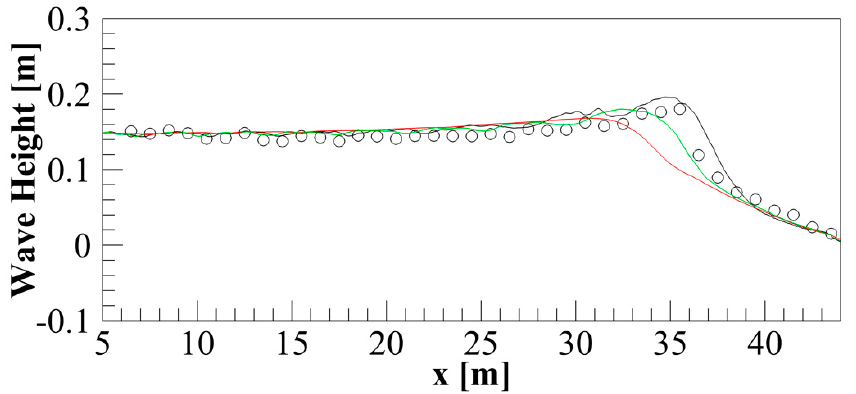
Figure 2. Test 1. Spilling breaking wave. Mean wave heights: comparison between experimental measurements by [18] (circles) and numerical results obtained with the WTENO model (black line), the 2TVD model proposed by Cannata et al. [3] (red line), and the 5WENO model (green line).